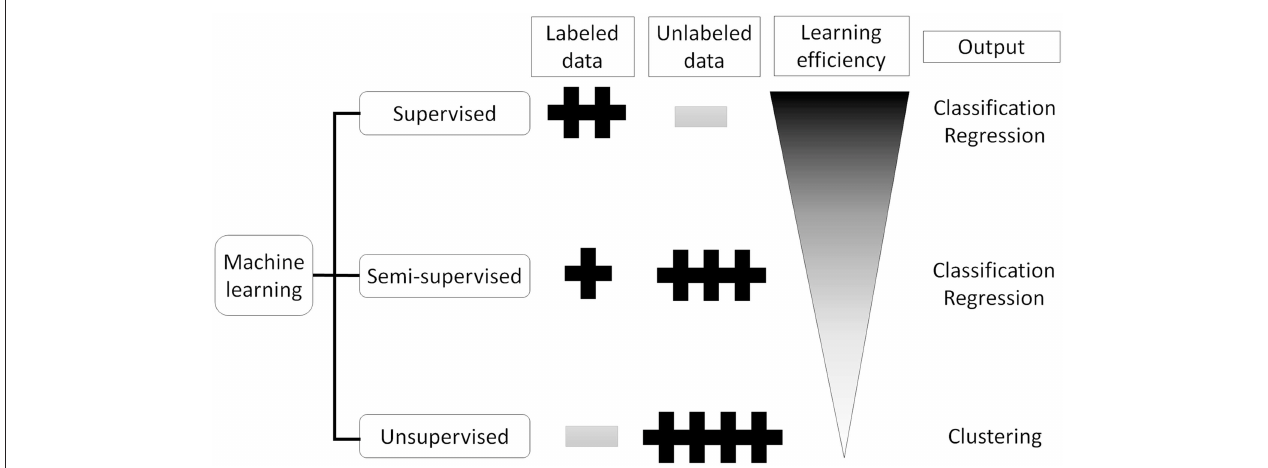
FIGURE 2 | Supervised, semi-supervised, and unsupervised training. Supervised training needs labeled data but can learn the most efficient. Unsupervised training does not need labeled data which sometimes difficult to prepare, but can only cluster the input data. Semi-supervised training can produce labeled data from unlabeled data using small number of labeled